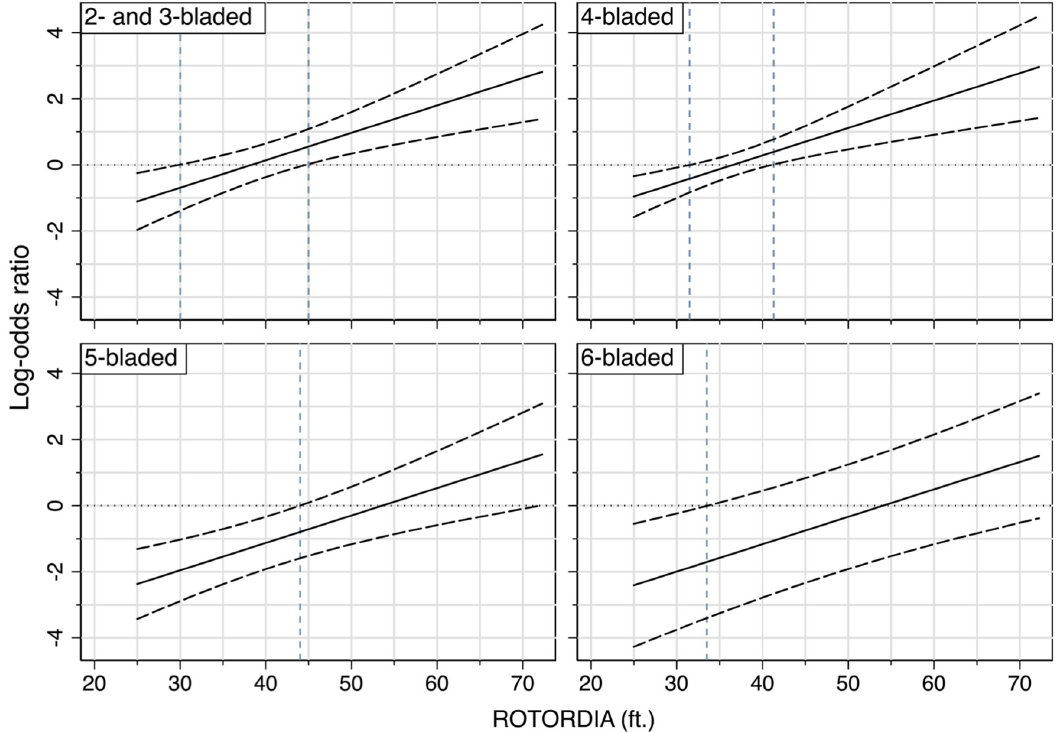
Fig 4. The estimated log-odds ratio for twin- versus single-engine turboshaft helicopters and associated 95% confidence interval.